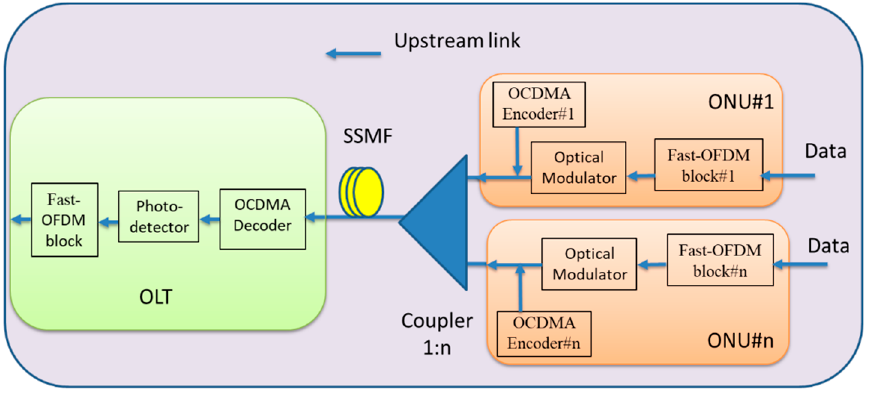
Figure 1. IM/DD Fast-OFDM-CDMA system architecture. Figure 1. IM / DD Fast-OFDM-CDMA system